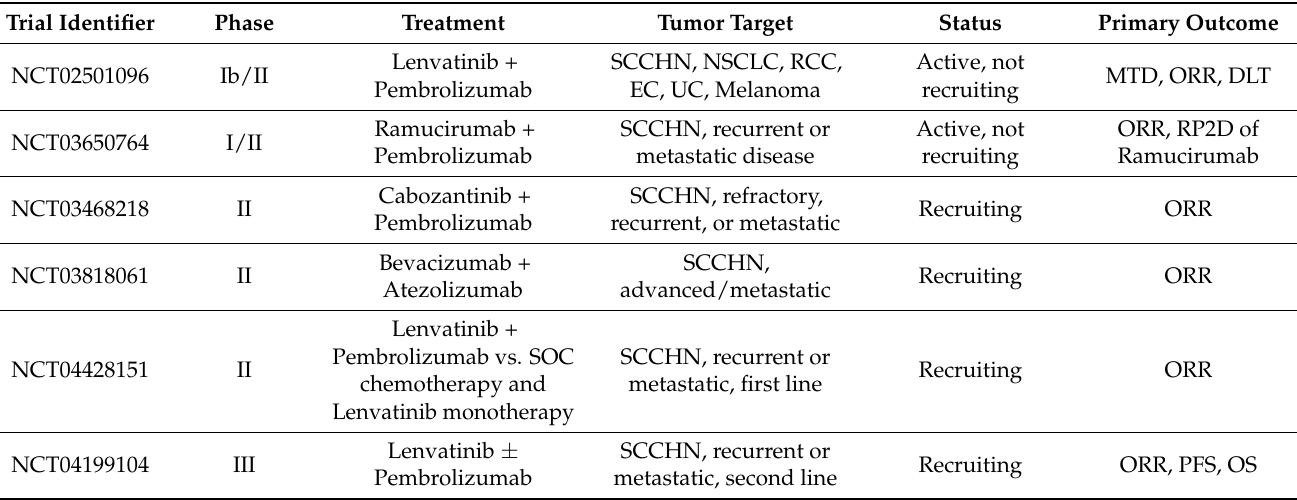
Table 1. Ongoing trials combining anti-angiogenic agents with immunotherapy in